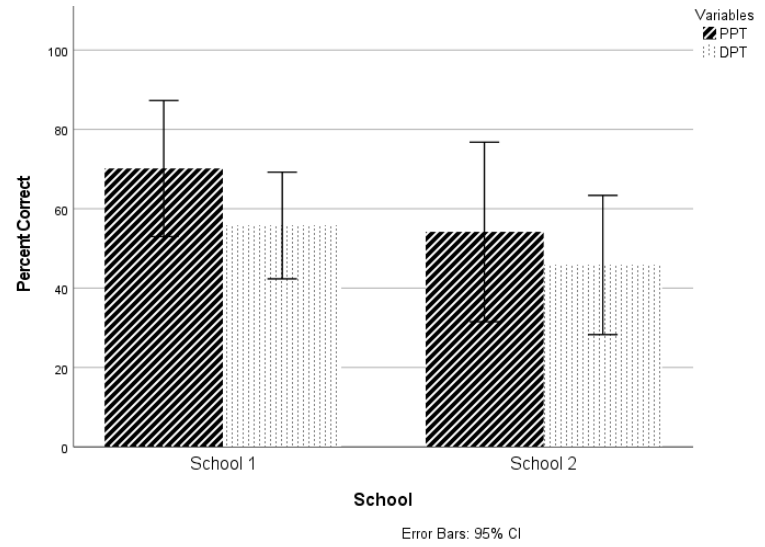
Figure 2. Mean percent correct scores and error bars (95% CI) for temporal sequencing tasks (PPT and DPT for each group).